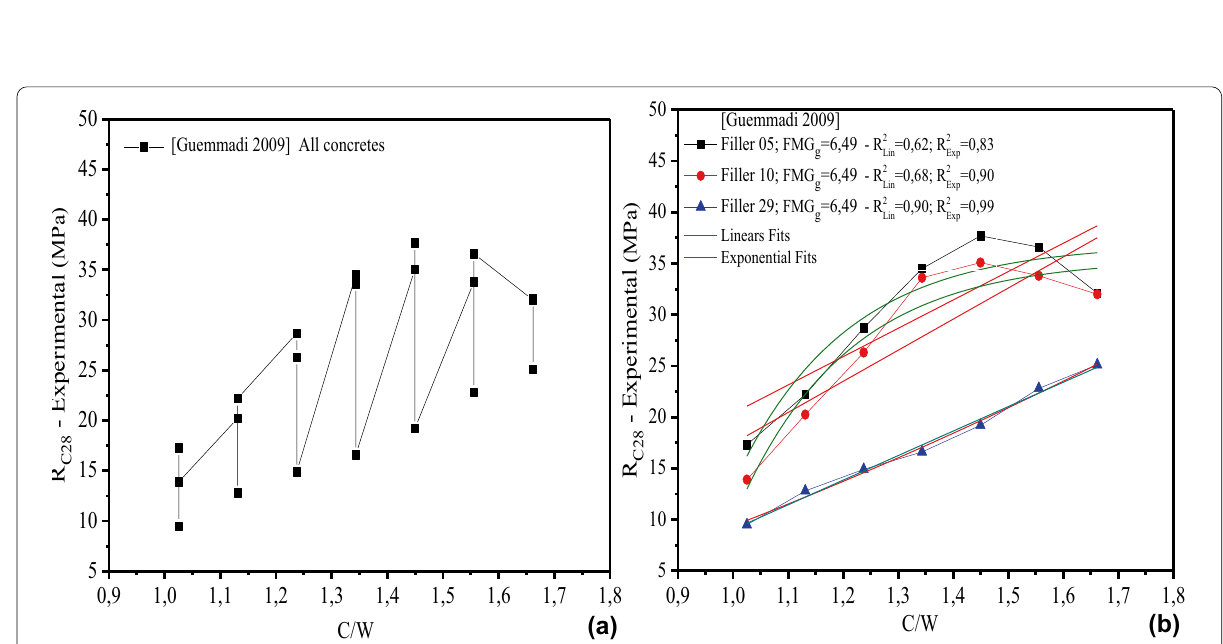
Fig. 14 Evolution of R C28 as a function of the ratio C / W Guemmadi et al. (2009). a Results obtained for all the concretes using, b results given by FGM g and FGM C